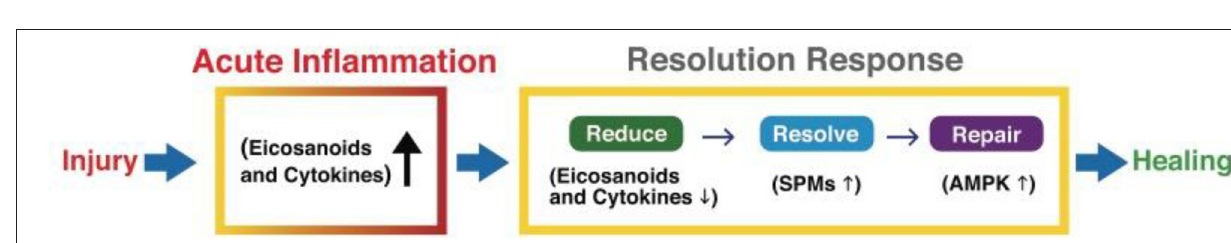
FIGURE 2 | A graphic illustration of the sequential events for a successful Resolution Response to injury-induced inflammation. AMPK, 5’ adenosine monophosphate-activated protein kinase; SPMs, Specialized pro-resolving meditators.